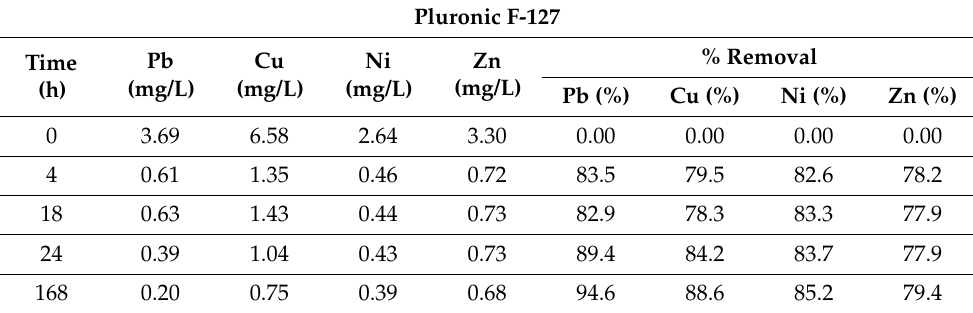
Table 9. Removal of Pb(II), Cu (II), Ni (II) and Zn (II) by a suspension of 0.01% ( w / w ) of MWCNTs with 0.03% ( w / w ) of Pluronic F-127, under competitive adsorption conditions between cations. Pluronic